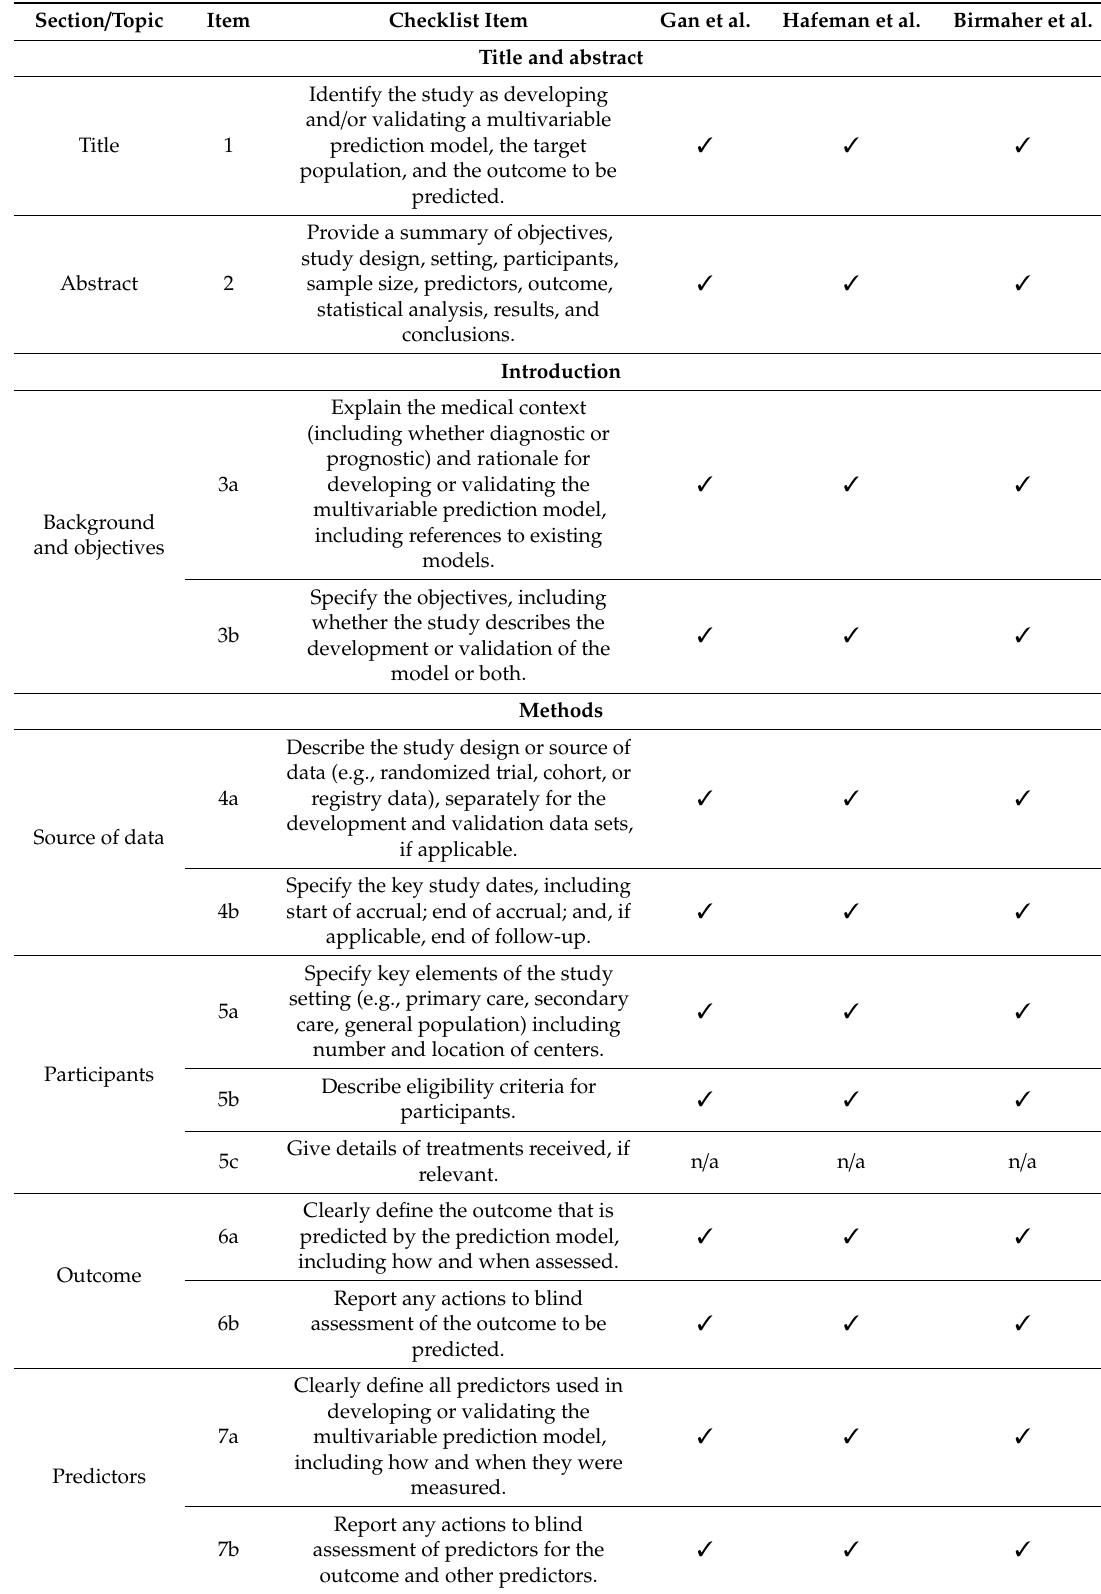
Table 3. Quality assessment of the calculators according to the Transparent Reporting of a multivariable prediction model for Individual Prognosis Or Diagnosis (TRIPOD)